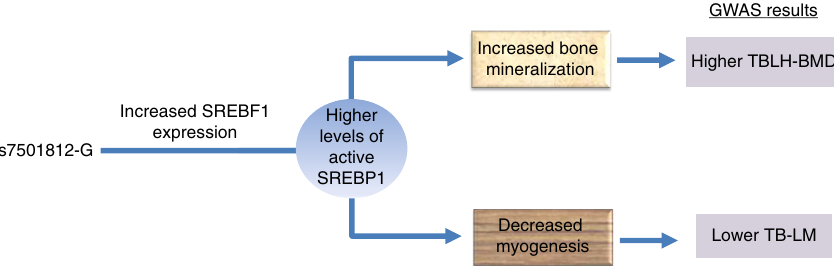
Fig. 5 Schematic representation of the plausible role of rs7501812 in the pleiotropic modulation of BMD and lean mass. The G-allele from rs7501812 upregulates the expression of SREBF1 both in skeletal muscle and bone. This overexpression would be expected to result in higher levels of the active form of SREBP-1. SREBP-1 exerts opposite effects on bone and muscle biogenesis. While it promotes osteoblast mineralization 45 , it inhibits myoblast differentiation 44, 46 . Ultimately, this modulation would result in higher BMD and lower lean mass, as we observed in our bivariate GWAS